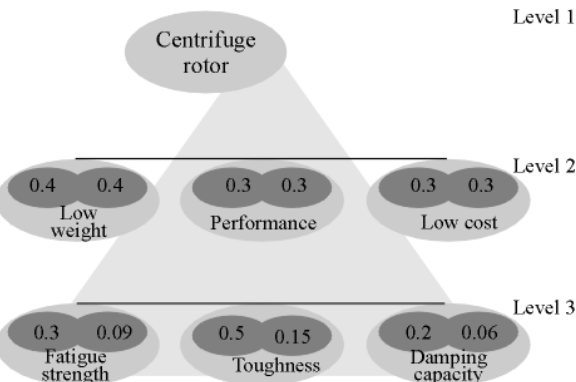
Figure 8. Pahl and Beitz decision matrix illustrating the functional description of the centrifuge rotor, the various criteria and the correspon- dent wheighting factors (w ij